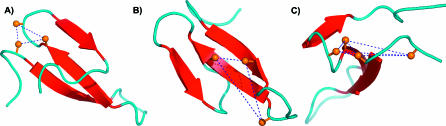
Important Higher-Order Clusters for the Expansion of WW-Domain EnergiesOrange balls represent the location of the Cβ atoms of side chains.(A) A structurally compact cluster corresponding to short-range interactions.(B) A more disperse cluster arising from long-range electrostatic interactions.(C) Quadruplet cluster with many contributing CFs corresponding to a wide range of amino-acid types.